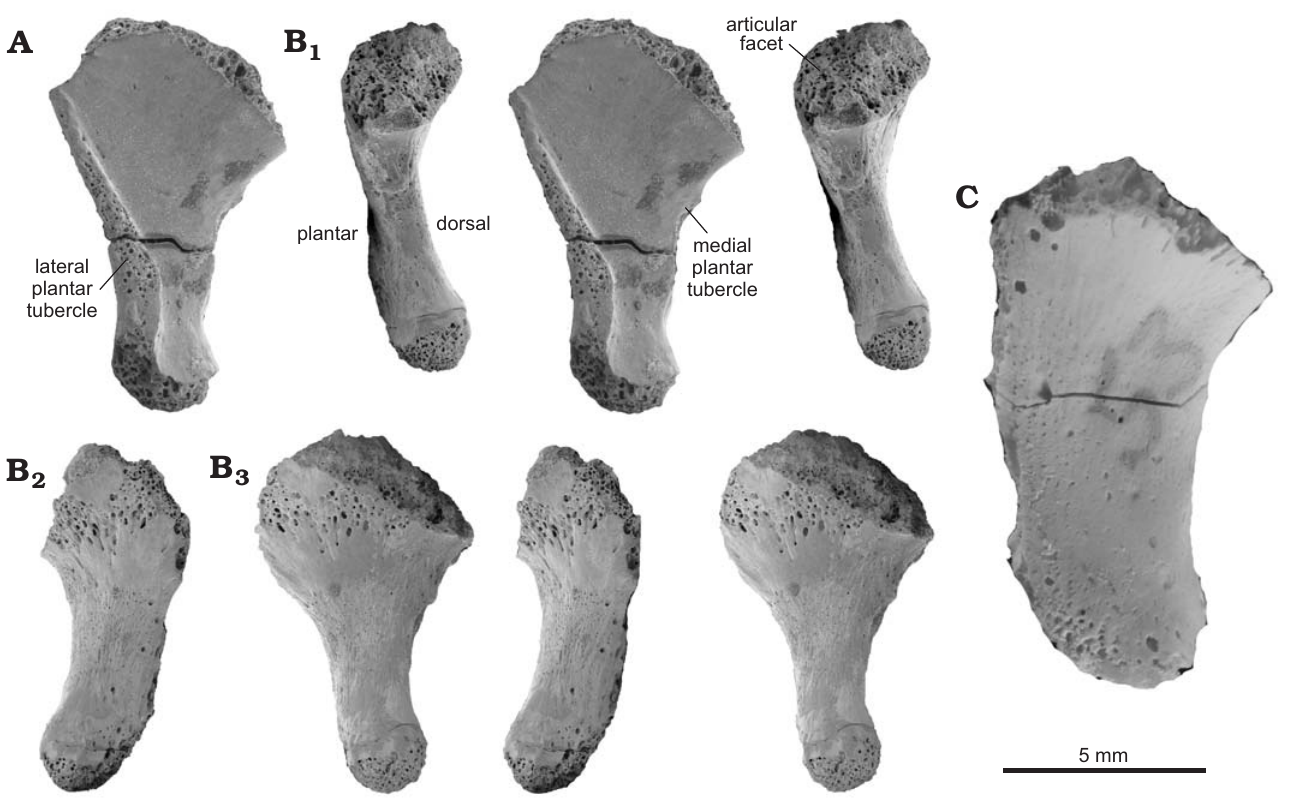
Fig. 3. Archosauriform Osmolskina czatkowicensis Borsuk-Bia ł y nicka and Evans, 2003 (A, B) and Archosauriformes gen. et sp. indet (C) all from the Lower Triassic Czatkowice locality, Poland. A . ZPAL RV/1347, adult, left MttV in plantar view. B . PAL RV/1346, young adult, right MttV in medial (B 1 ), lateral (B 2 ), and dorsal (B 3 ) views. B 1 , B 2 , reversed. C . ZPAL RV/1993, right MttV in dorsal view. SEM photographs; A, B,